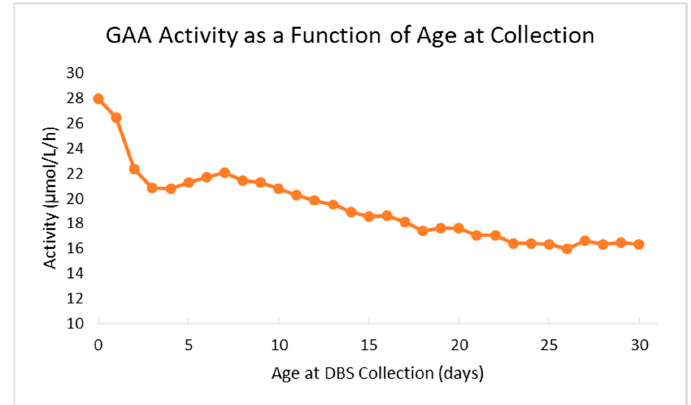
Figure 2. GAA enzyme activity decreases during the first 30 days of life. GAA enzyme activity data (Y axis) from this chart includes average screening results from 338,743 full-term newborns (>38 weeks gestational age) prospectively screened at MSPHL. Age at DBS sample collection (X axis) was rounded down to the nearest full day.